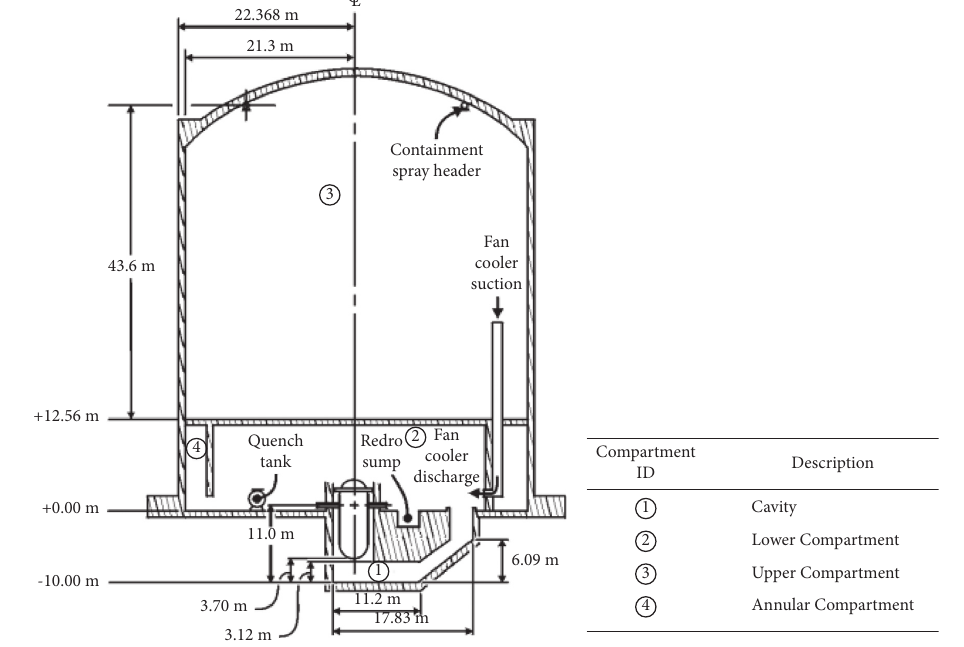
Figure 3: Containment